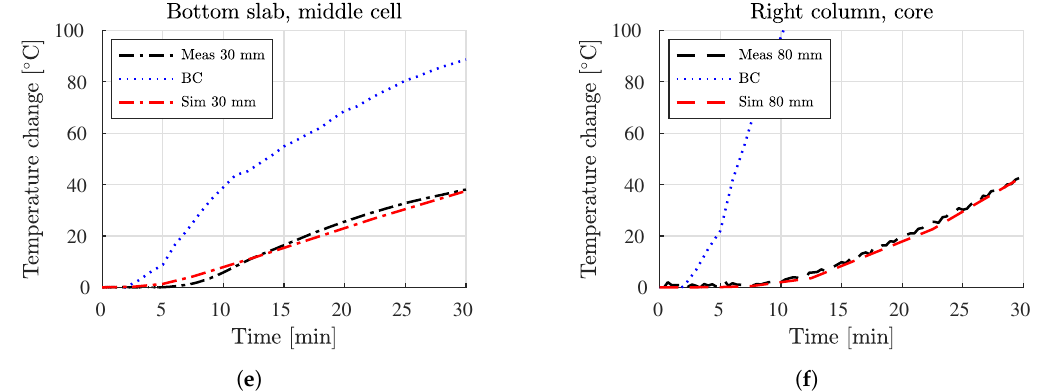
Figure 14. Comparison of the simulated evolutions of the temperature inside the analyzed structure, obtained by prescribing three piecewise spatially-uniform temperature histories along the inner surface, with experimental data: ( a ) top slab, at the midspan of the middle cell, ( b ) top slab, at the midspan of the right cell, ( c ) top slab, at the midspan of the left cell, ( d ) center of the right wall ( e ) bottom slab, at the midspan of the middle cell, and ( f ) core of the right column.